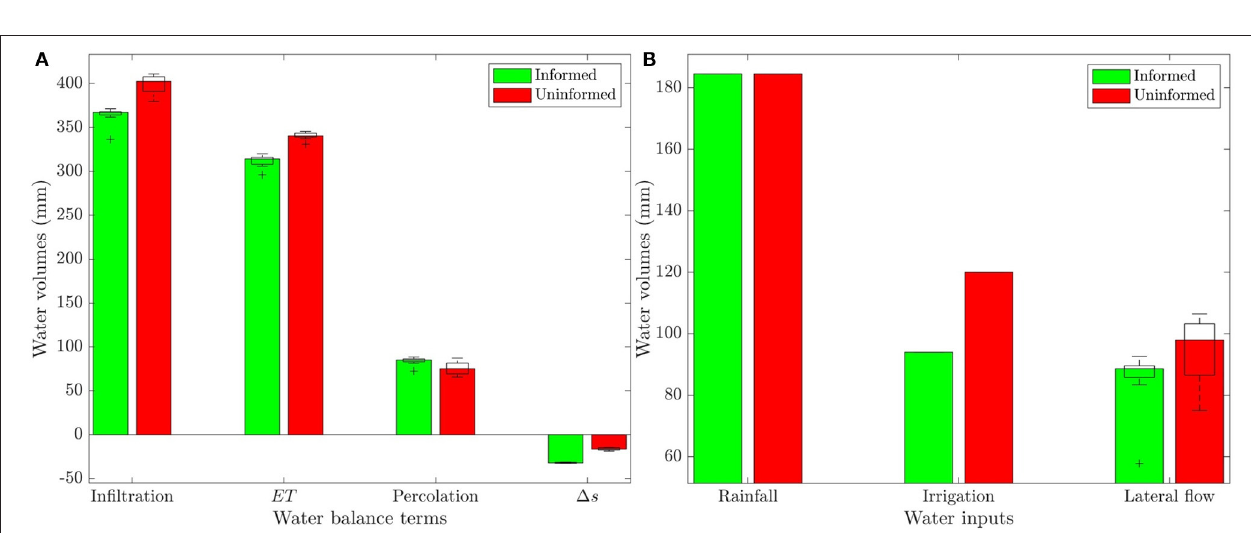
FIGURE 4 | Comparison between (A) the water balance terms and (B) the different sources of water input (total infiltration) in the informed and uninformed sites as computed with the calibrated soil moisture dynamics model ( ET and 1 s are evapotranspiration and water storage change, respectively). The box plots of the simulations with the ten final sets of parameters derived with DREAM overlap the colored bars (median values). The bottom and top edges of the boxes indicate the 25th and 75th percentiles, respectively, the whiskers extend to the maximum and minimum values not considered outliers, and the outliers are marked by the “+” symbol. Note that rainfall and irrigation were not considered uncertain in the